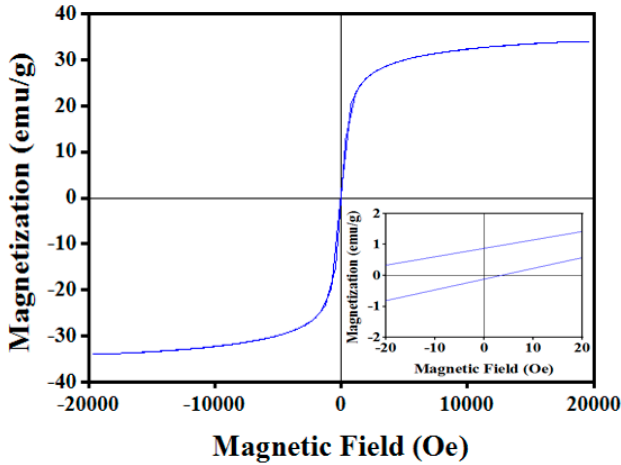
Figure 6. Hysteresis loop of the C-Fe 3 O 4 nanoparticles, inset is the magnified low field hysteresis curve.